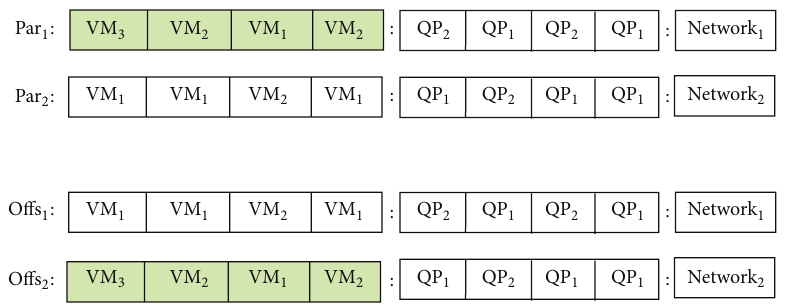
Figure 6: Global crossover operator for the multiobjective optimization of query workloads.